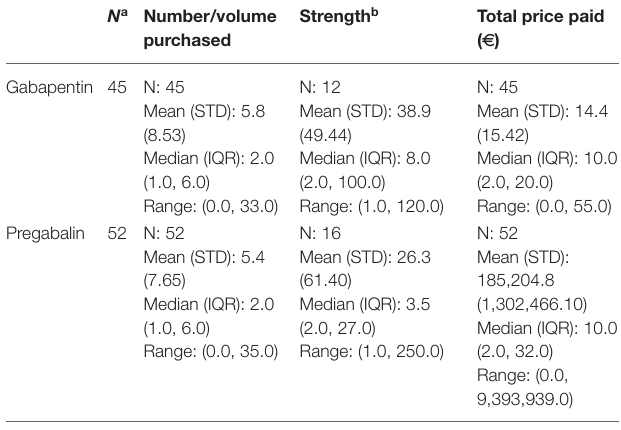
TABLE 8 | Last purchase characteristics in